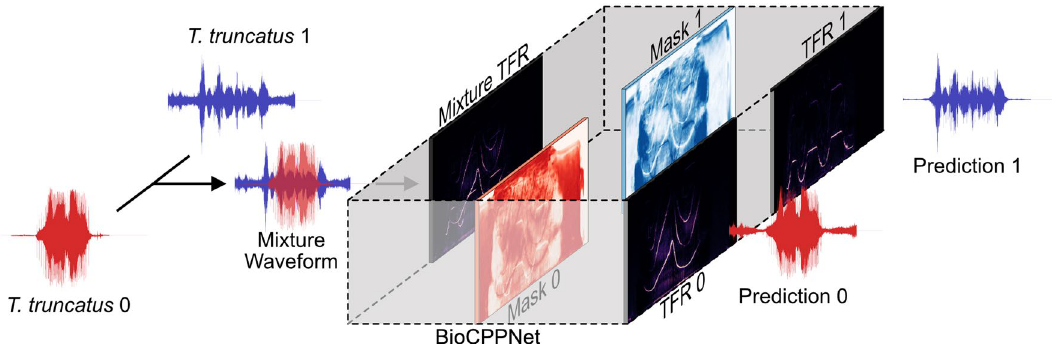
Figure 2. Schematic diagram demonstrating the application of BioCPPNet to dolphin signature whistles using handcrafted STFT-based encoders and decoders. The source waveforms produced by N speakers of unique identity (e.g. T. truncatus 0 and T. truncatus 1) are overlapped in time, summed, and transformed to time- frequency space using an STFT layer, resulting in the mixture time-frequency representation (Mixture TFR). The U-Net predicts masks (Mask 0 and Mask 1) that are applied to the mixture representation. The separated spectrogram estimations (TFR 0 and TFR 1) are inverted using an iSTFT layer to yield the model’s predictions for the separated raw waveforms, which are compared to the ground truth waveforms and classified according to predicted identity using the classification